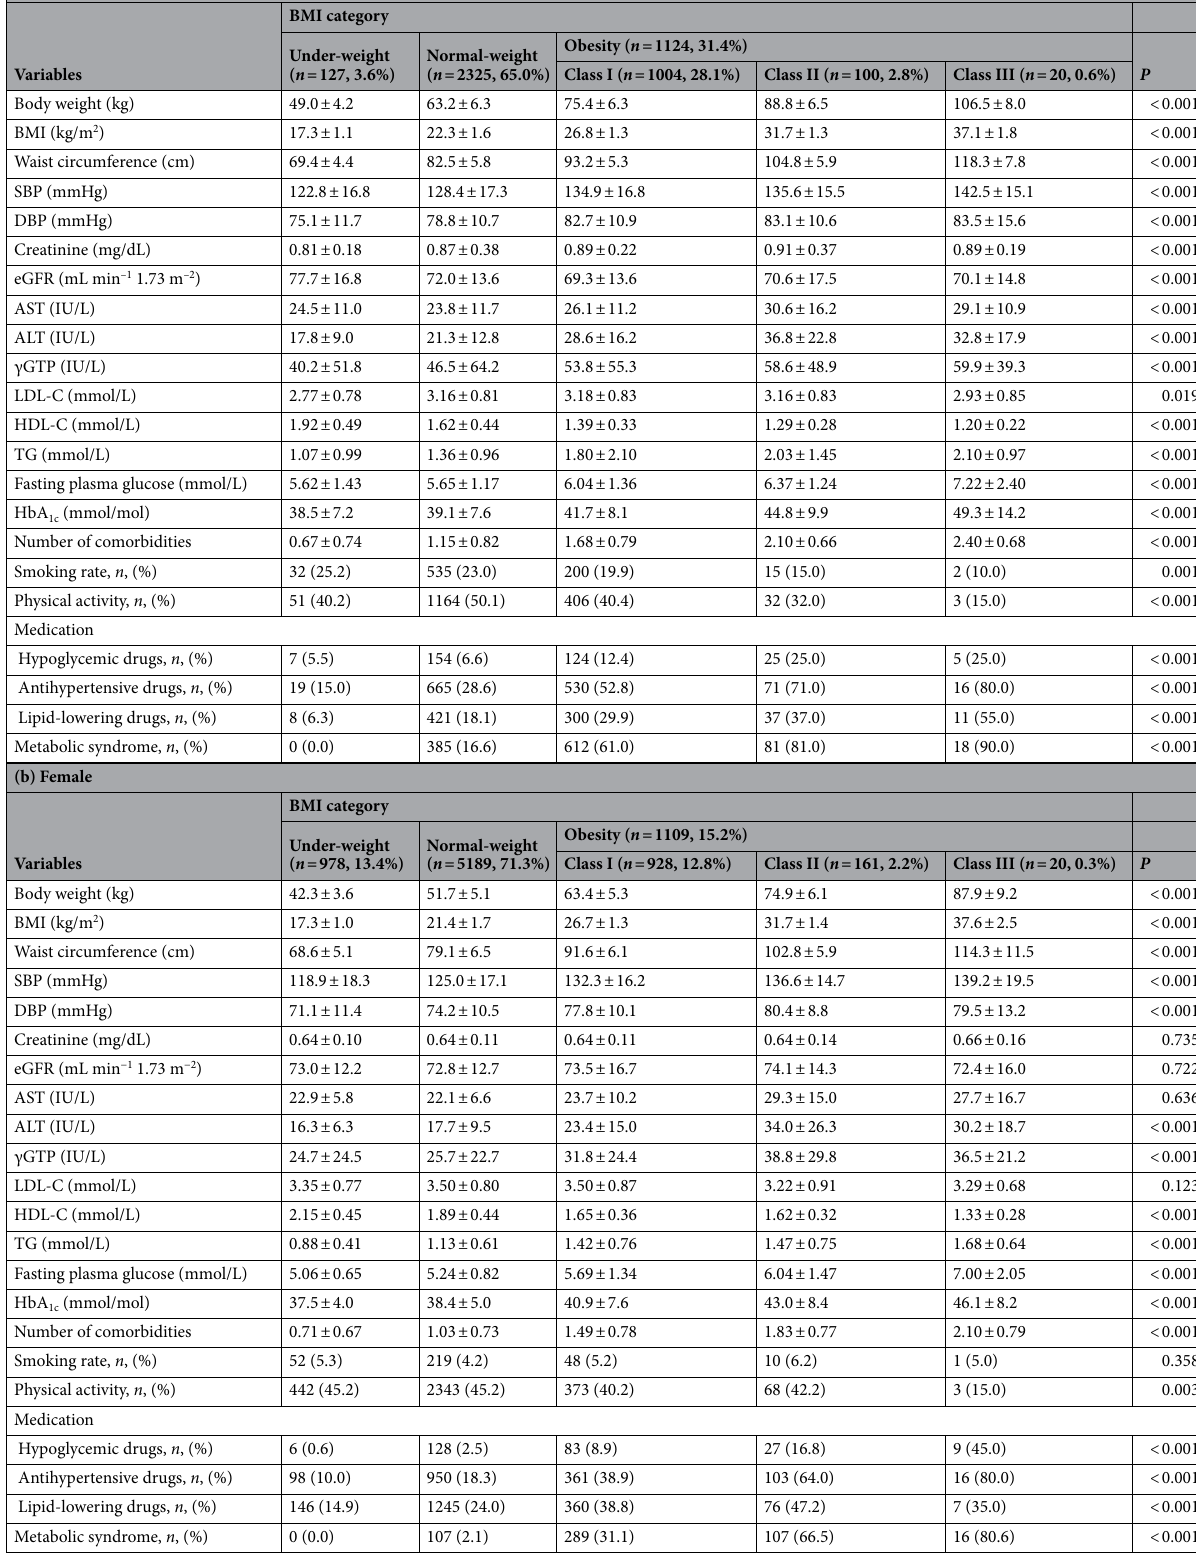
Table 3. Characteristics of study participants by BMI category. Data are mean ± SD or n (%). All abbreviations are defined in the text. P values were calculated with the Jonckheere–Terpstra trend test or the Armitage trend test as